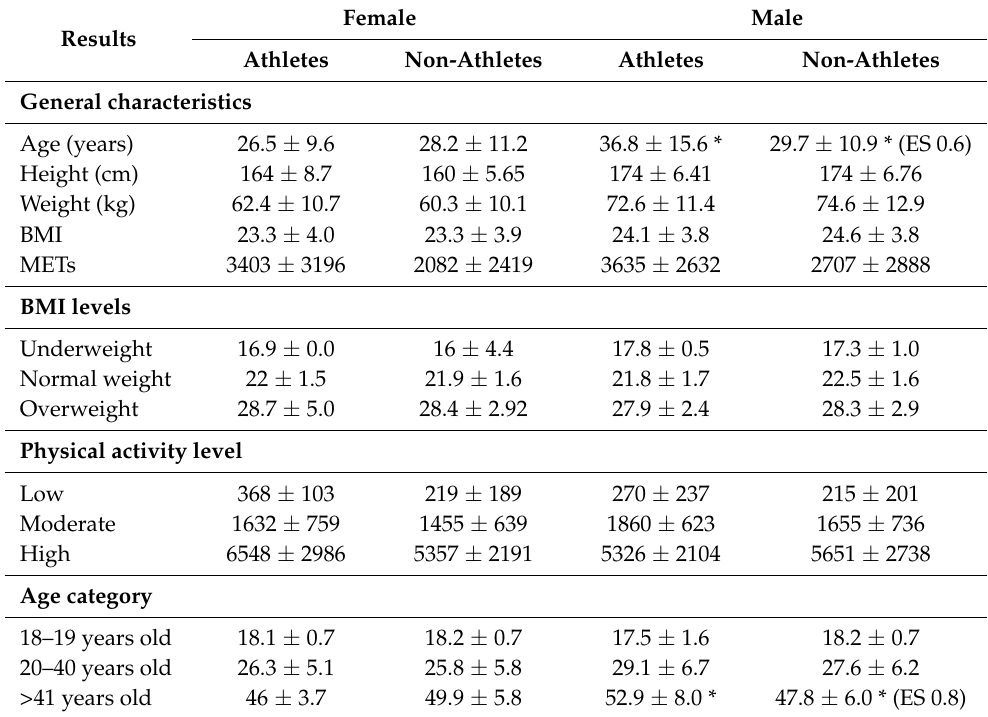
Table 2. The description of the categorical results according to general characteristics, BMI level, physical activity level, and age category (comparison between sex and